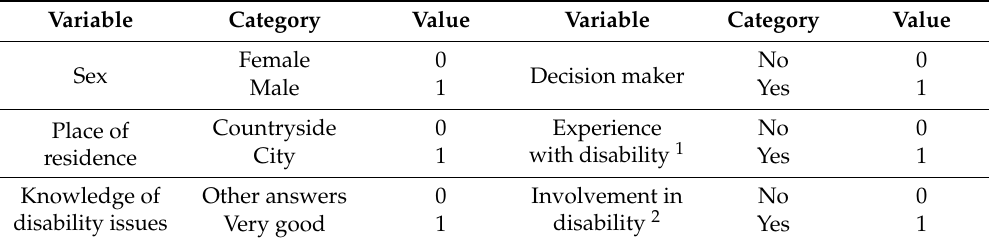
Table 5. Potential binary independent variables in logistic regression.